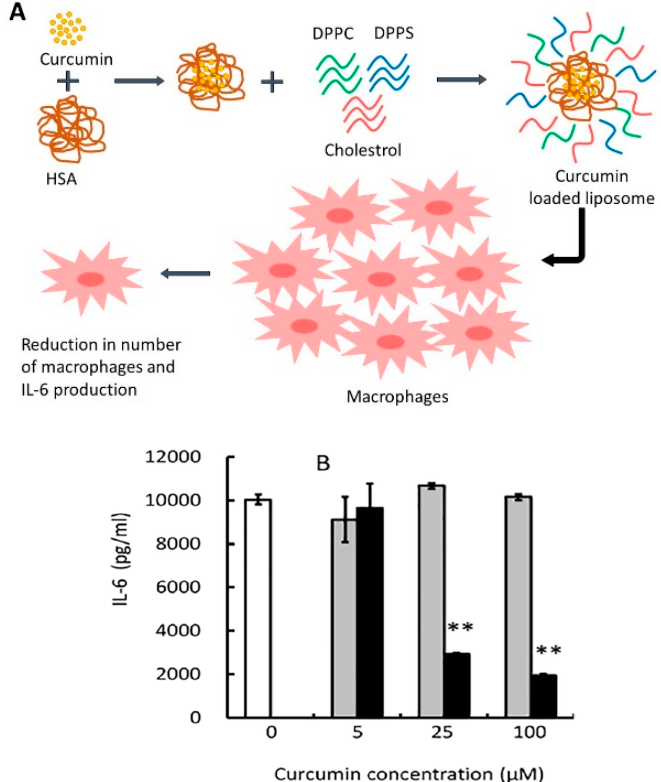
Figure 3. ( A ) Schematic representation of curcumin-loaded liposomes inducing a reduction in the